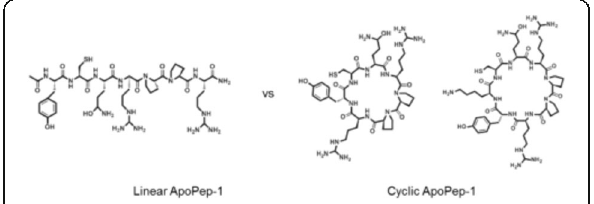
Fig. 1 (abstract PP34). Chemical structure of linear and cyclic ApoPep-1